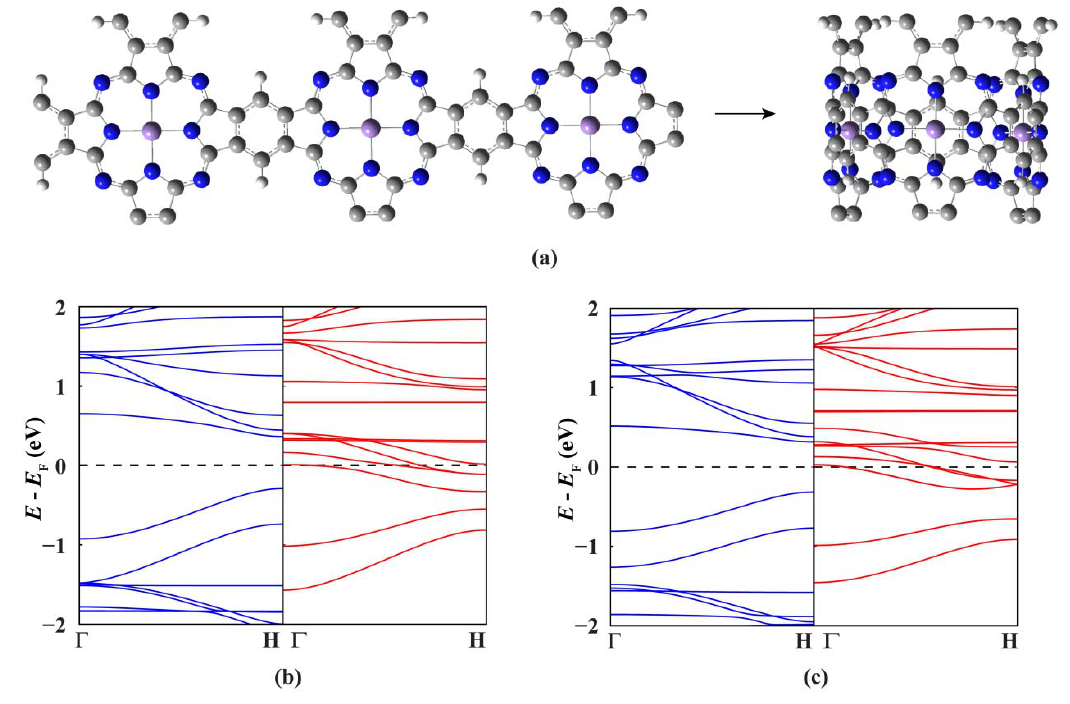
Figure 2. The optimized geometry structure of one unit cell ( a ) and the spin-resolved band structure ( c ) of the MnPc-3 nanotube, the spin-resolved band structure ( b ) of the MnPc nanoribbon with the same number of MnPc monomers along its width are given for